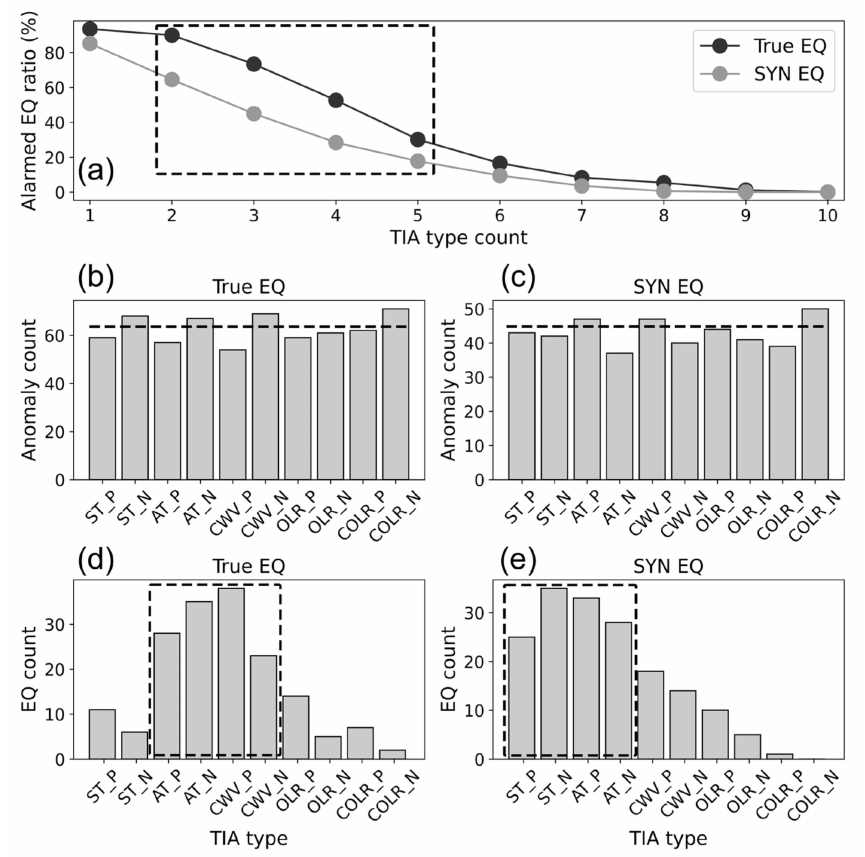
Figure 7. Statistical results of multiparametric temporal integrated anomaly (TIA) trends for true and synthetic (SYN) earthquakes (EQ). ( a ) Alarmed earthquake ratios as a function of TIA type counts for TIAs based on 5 parameters multiplied by 2 types of positive or negative anomalies; anomaly counts of different TIA types for ( b ) true and ( c ) synthetic earthquakes; “P”/“N” before the underscore denotes positive or negative TIA (e.g., ST_P is positive skin temperature TIA); earthquake counts of different TIA types for ( d ) true and ( e ) synthetic